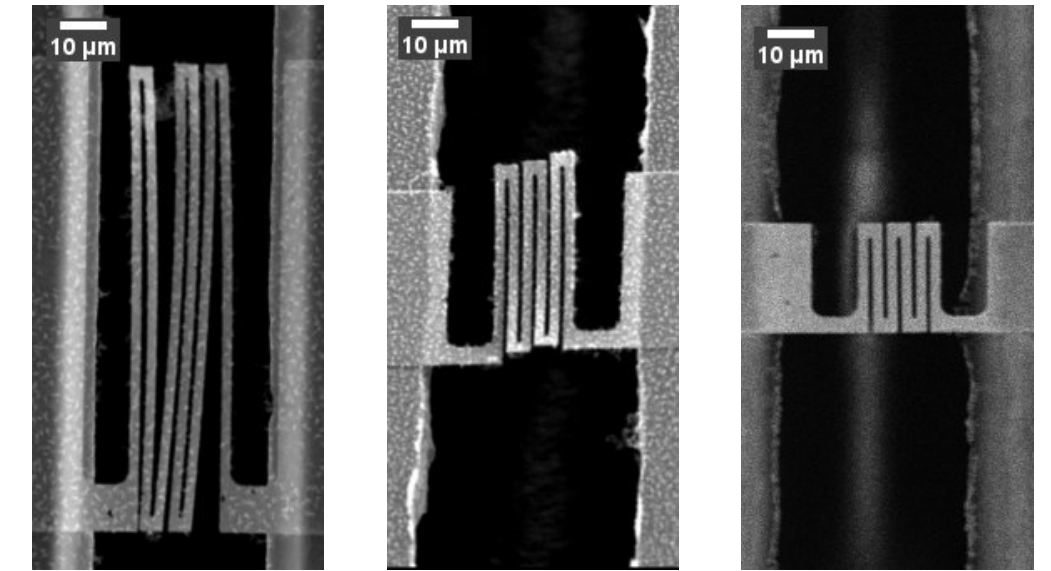
Figure 5. ( a ) SEM image of the notching points of the beams; ( b ) The pre-designed reduction of thickness of the temporary support beams at the v-notch points is clearly visible in the SEM cross section.